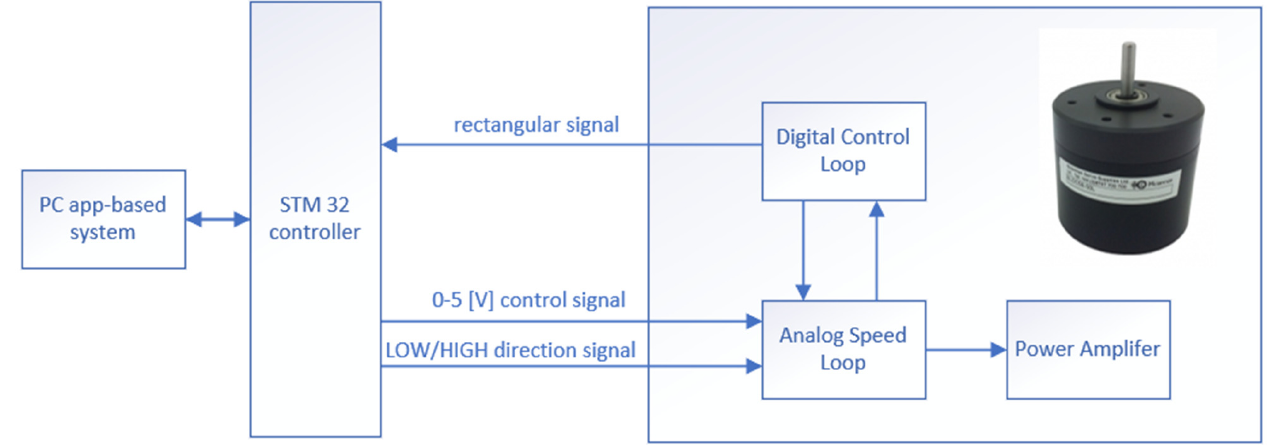
Figure 5. Rotation speed controller connection.